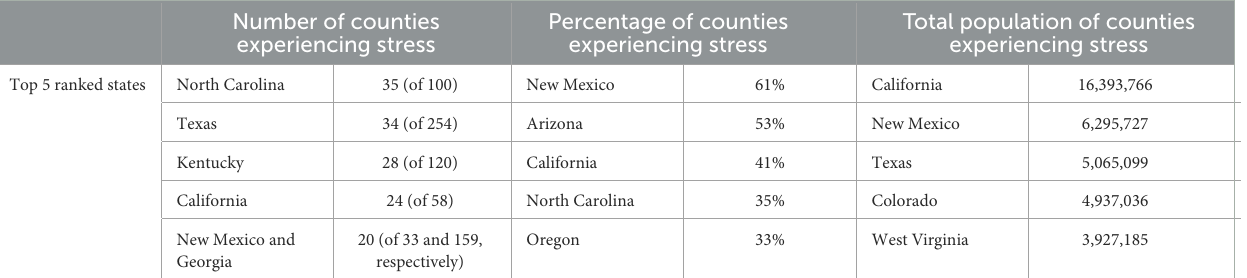
TABLE 3 As in Table 2—but for the combinatory risk metric of water stress, water quality, and population below the poverty